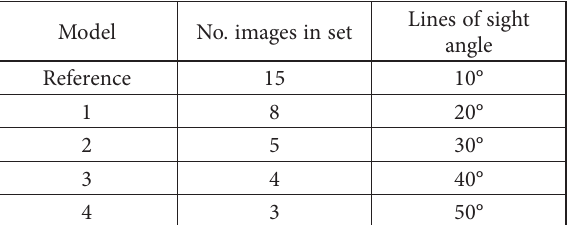
Table 3. 3D model feature comparison